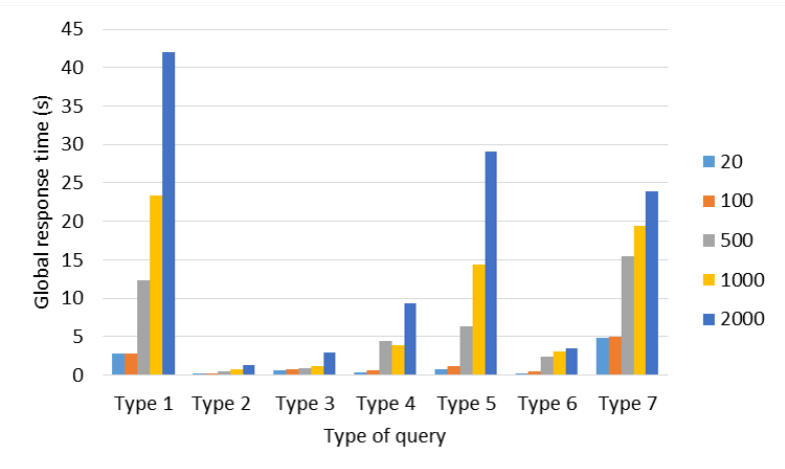
Figure 6. Global response times with respect to the type of